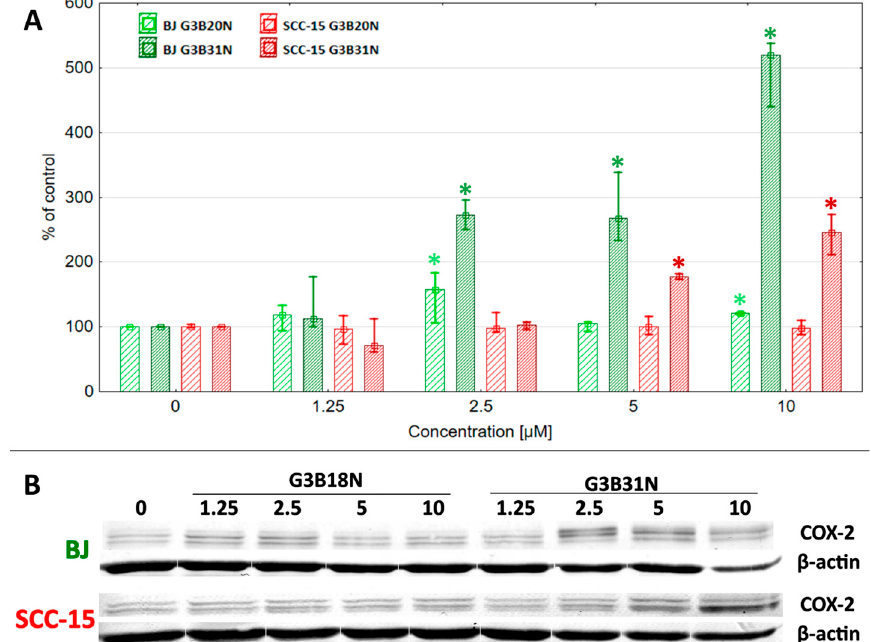
Figure 6. E ff ect of G3 BN18 and G3 BN31 on expression of COX-2 protein in human normal fibroblasts (BJ) and squamous carcinoma cells (SCC-15). ( A ) Levels of COX-2 protein calculated against β -actin were presented as the percent of the control. Squares indicates medians and whiskers correspond to the lower (25%) and upper (75%) quartile ranges. * p < 0.05 significant di ff erence against control (Kruskal–Wallis test). ( B ) Representative images of Western